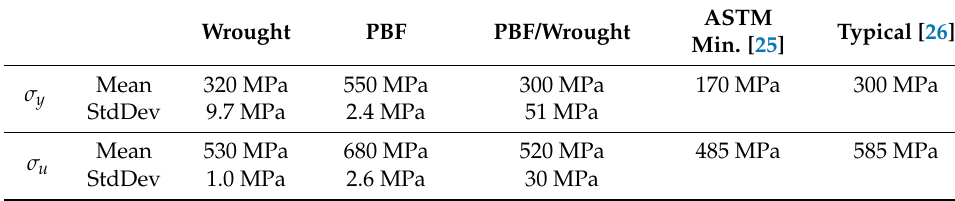
Table 2. Measured tensile properties.